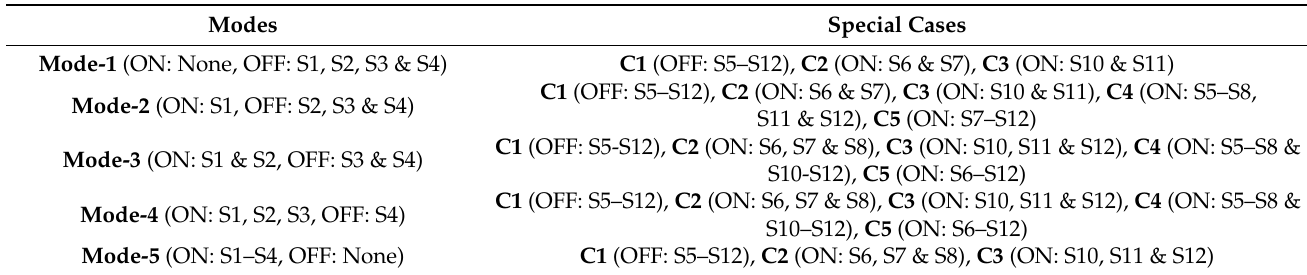
Table 2. Different mode of switching for frequency reconfiguration.